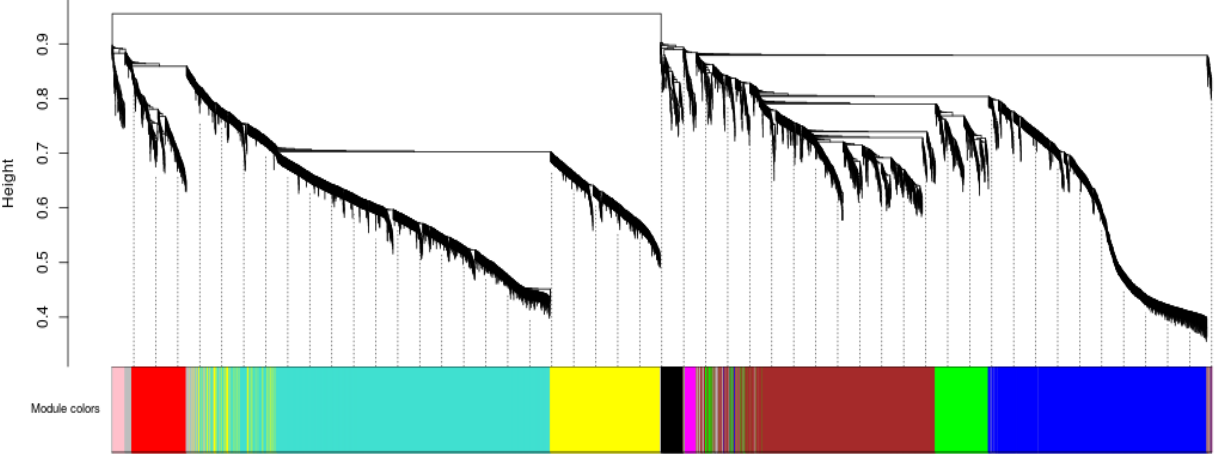
Figure 6. Weighted gene co-expression network analysis (WGCNA). Genes are classified into modules according to their expression trends, where a branch represents a gene, and each color represents a module. A gray color represents a gene that is not classified into a specific module.